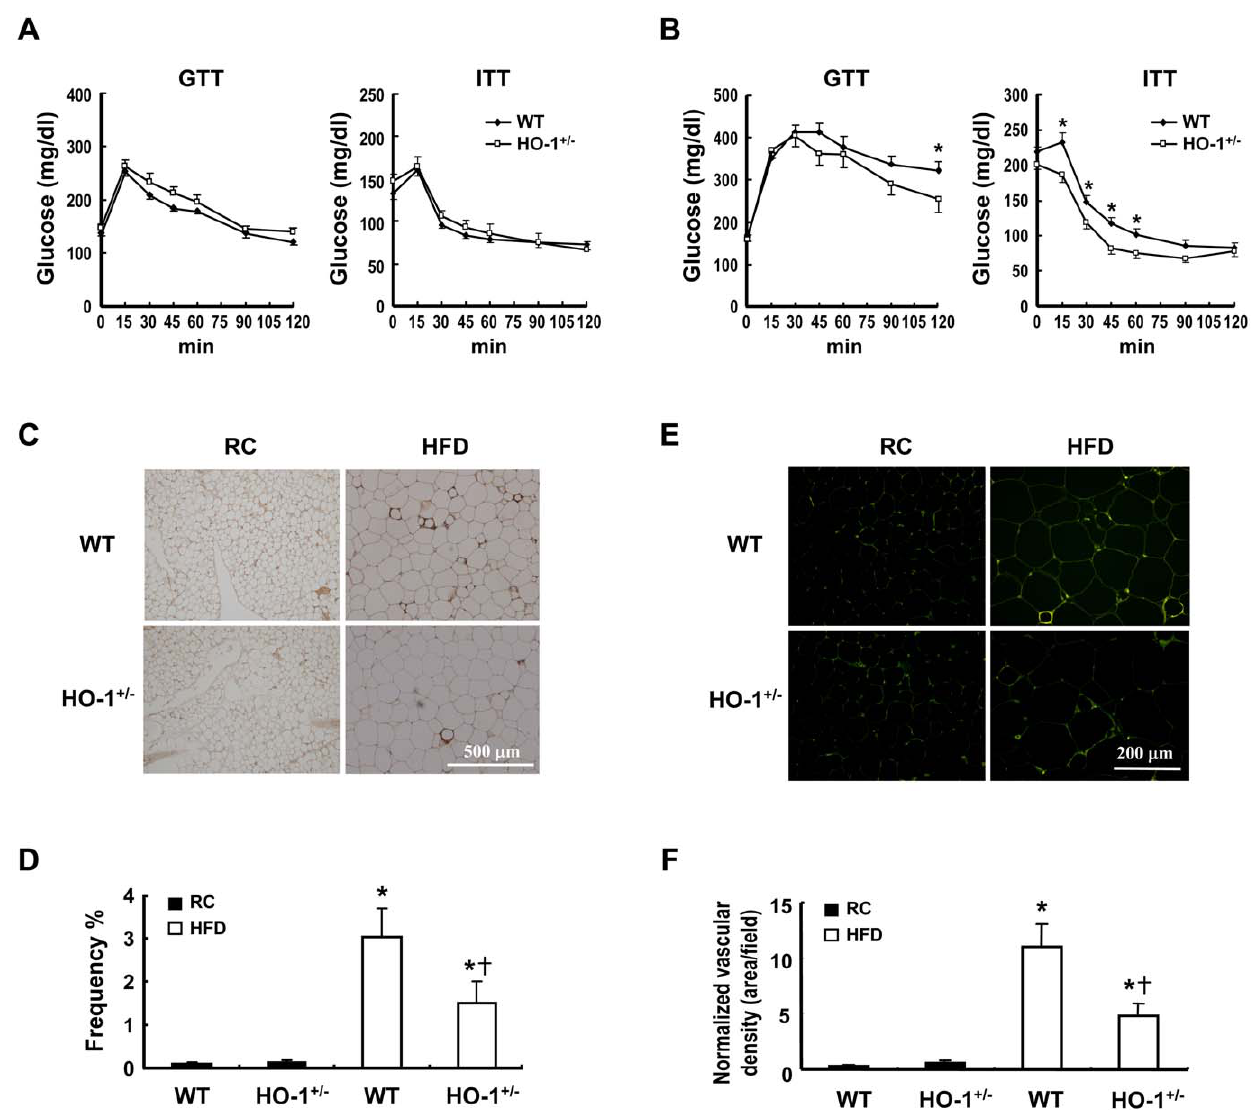
Figure 3. HO-1 haploinsufficiency in hematopoietic cells protects mice from HFD-induced insulin resistance. A and B, Chimeric mice with transplanted WT or HO-1 + / 2 bone marrow were fed a regular chow (RC) diet (A) or a HFD (B), then a glucose tolerance test (GTT) and an insulin tolerance test (ITT) were performed at week 28. The number of animals in each group was nine or ten. * P , 0.05 vs WT chimeras. C and E, The animals were sacrificed after 36 weeks on the different diets and the visceral fat tissue immunostained using antibody against F4/80 (C) or CD31(E) as described in the Materials and Methods. D, F4/80-positive macrophages were quantified as the percentage of adipocytes surrounded by a crown-like structure in the total adipocytes. F, Normalized vascular density was quantified as the CD31-positive area divided by adipocyte density per field. * P , 0.05 vs the chow diet-fed group of the same genotype; { P , 0.05 vs HFD-fed WT group.